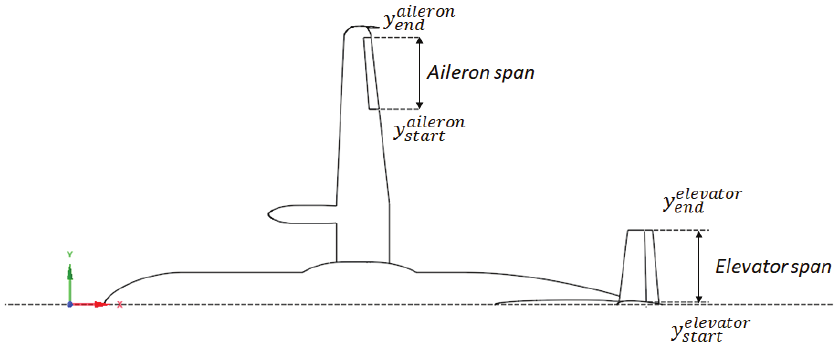
Figure 3. Control surfaces: geometrical